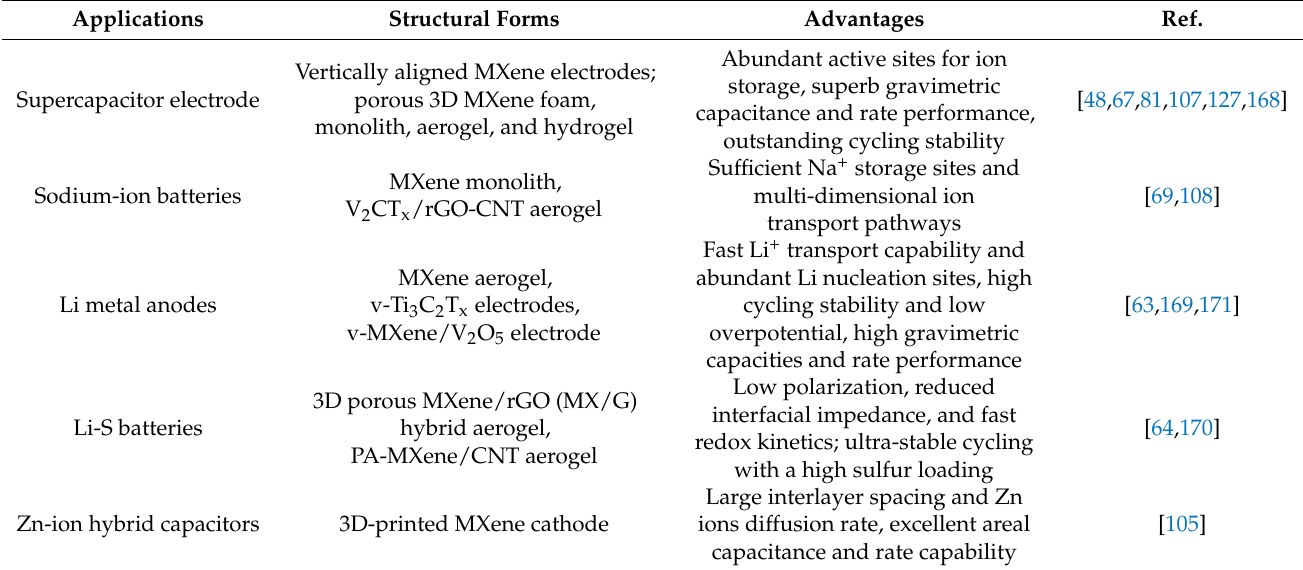
Table 1. Summary of MXene-based porous monoliths in energy storage and